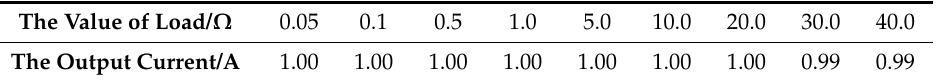
Figure 7. The diagram of resistance load capacity test. Table 1. The output current result of the different load test.